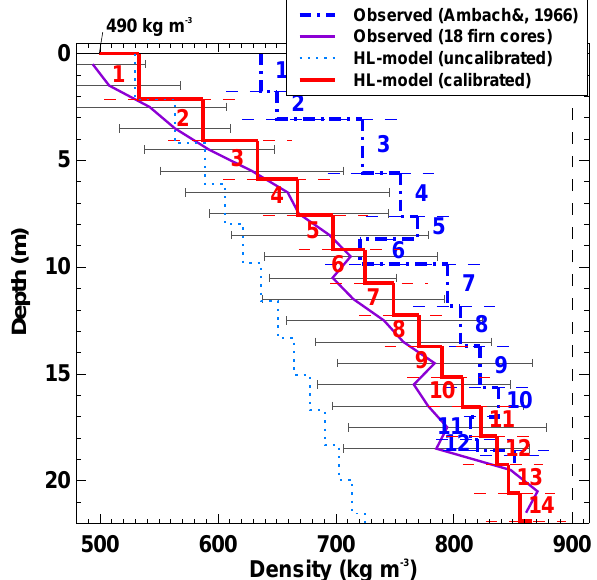
Fig. 2. Validation of calculated firn density (constant accumulation rate) against field measurements. Density of annual layers according to Ambach and Eisner (1966) and a mean density profile from 18 firn cores in different regions worldwide are shown ( ± 1 standard deviation given by grey bars). Numbers indicate the age of the firn layers in